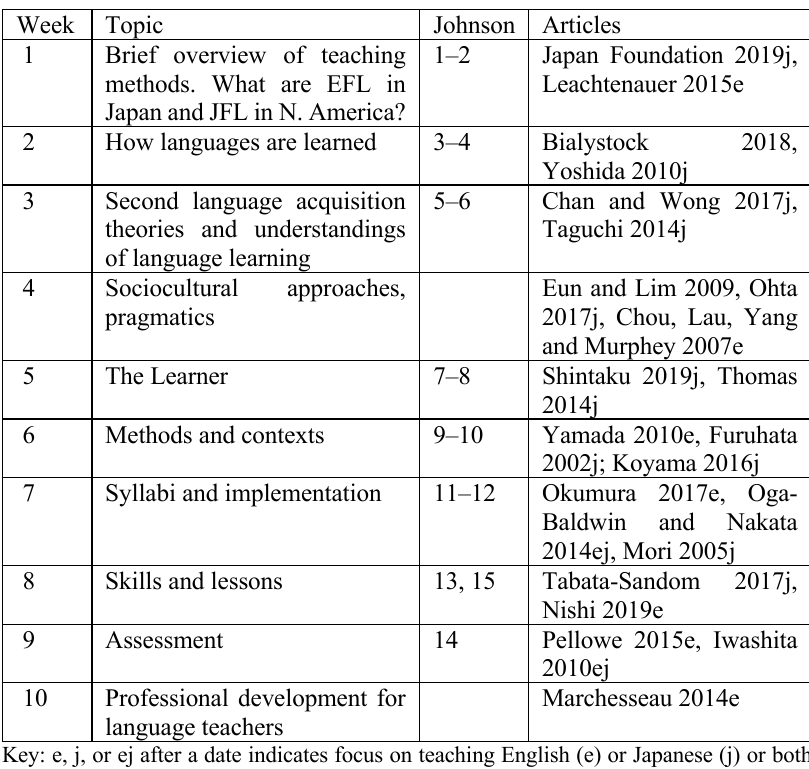
Table 1. A Tentative Schedule for “Foreign Language Teaching in the Japanese